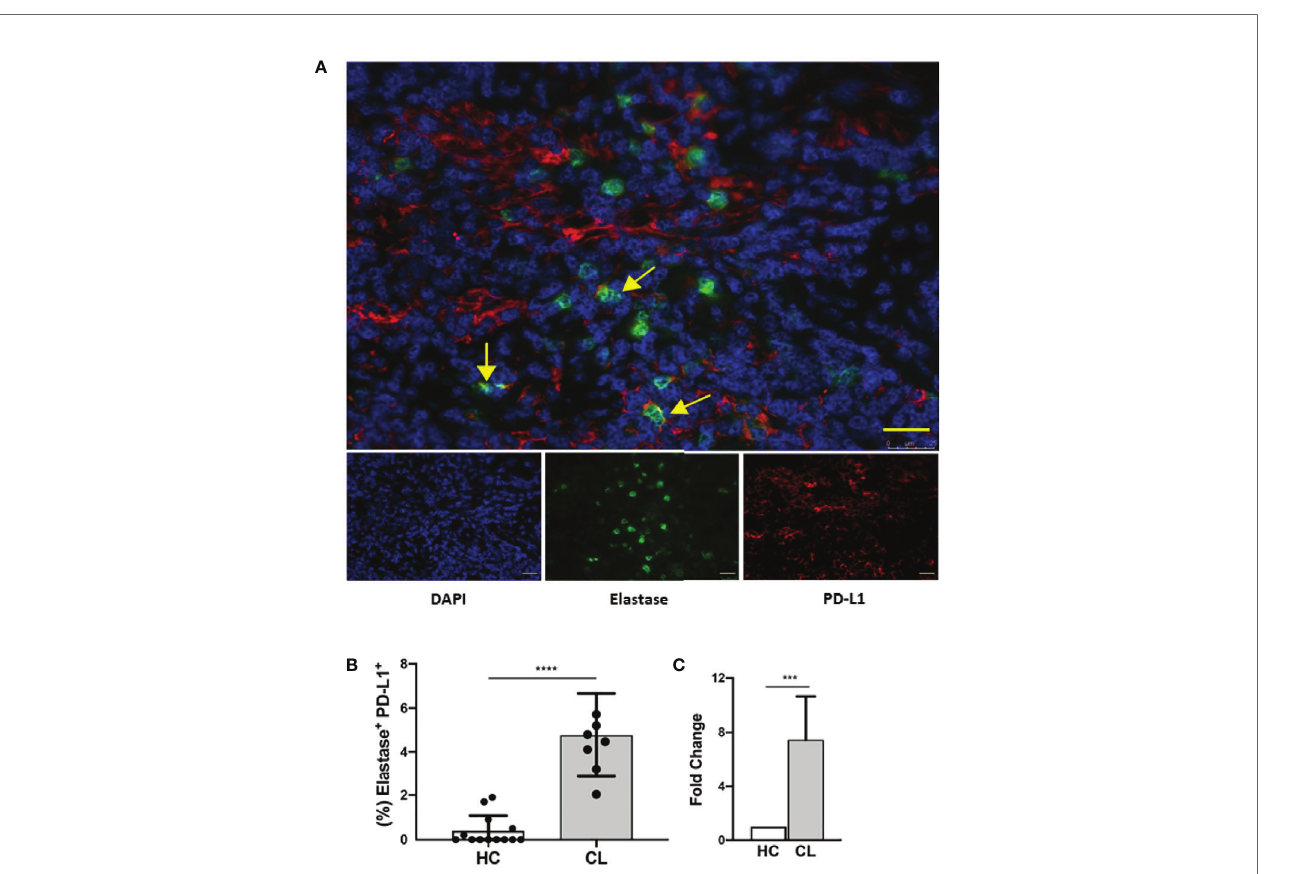
FIGURE 8 | Human lesion neutrophils present a conspicuous expression of PD-L1. Healthy human skin and human cutaneous leishmaniasis skin lesions were stained with anti-elastase (green), anti-PD-L1 (red) and counter-stained with DAPI (blue). (A) Representative immuno fl uorescence staining of a cutaneous leishmaniasis lesion. Yellow arrows indicate anti-PD-L1 and anti-elastase double-stained cells. Bars = 50 µm. (B) Frequency of elastase-positive PD-L1 + cells of cumulative data of PD-L1 in neutrophils in healthy control skin (HC, N = 12) and in cutaneous leishmaniasis skin lesions (CL, N = 7). (C) Frequencies of double- stained neutrophils were normalized and data are expressed as fold over the control. Data shown as median with 95% con fi dence. The p values were calculated using Mann-Whitney test. ***p <